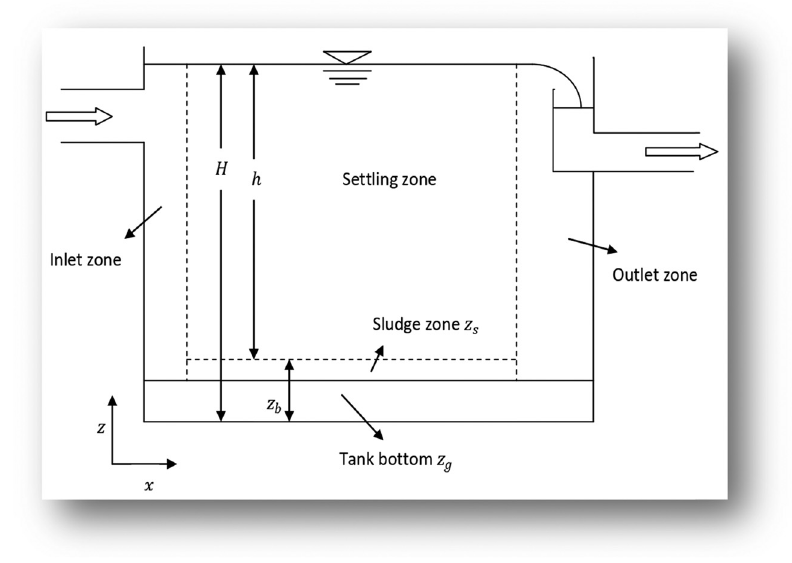
Figure 1: De fi nition sketch [ 7 ] .